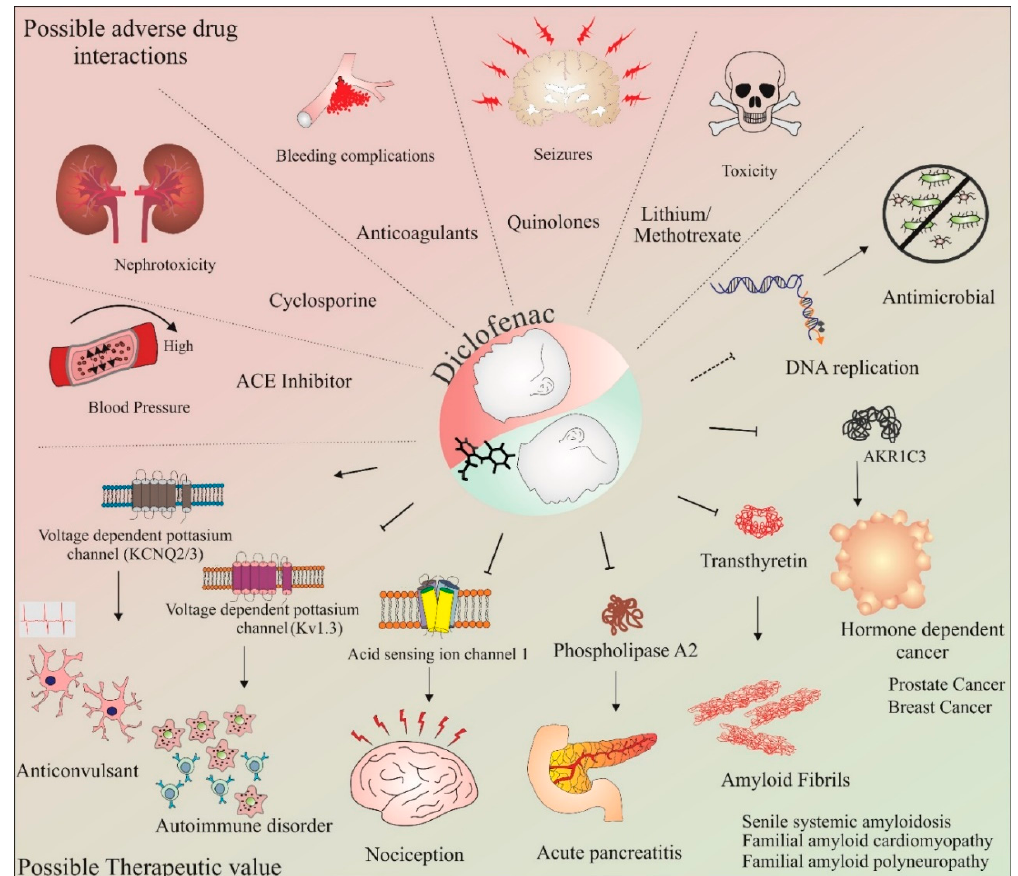
Figure 2. Therapeutic value and adverse drug–drug interactions of diclofenac. The potential use of diclofenac in combination therapies targeting various conditions has been assessed in numerous studies. However, some combinations of drugs with diclofenac have shown adverse effects. These include diclofenac in combination with ACE inhibitors, cyclosporine, anticoagulants, quinolones, and lithium/methotrexate. These combinations have resulted in increased blood pressure, nephrotoxicity, bleeding complications, seizures, and toxicity, respectively. In addition, with regard to its anti- inflammatory effects, studies have shown the therapeutic value of diclofenac in various diseases and conditions, such as autoimmune disorders, nociception, pancreatitis, amyloid fibril formation, seizures, cancer, and as an antimicrobial agent. The activation/formation and inhibition are depicted with arrows and blunt heads, respectively. The dotted blunt end represents an inhibitory effect that requires further investigations on diclofenac’s mechanism of